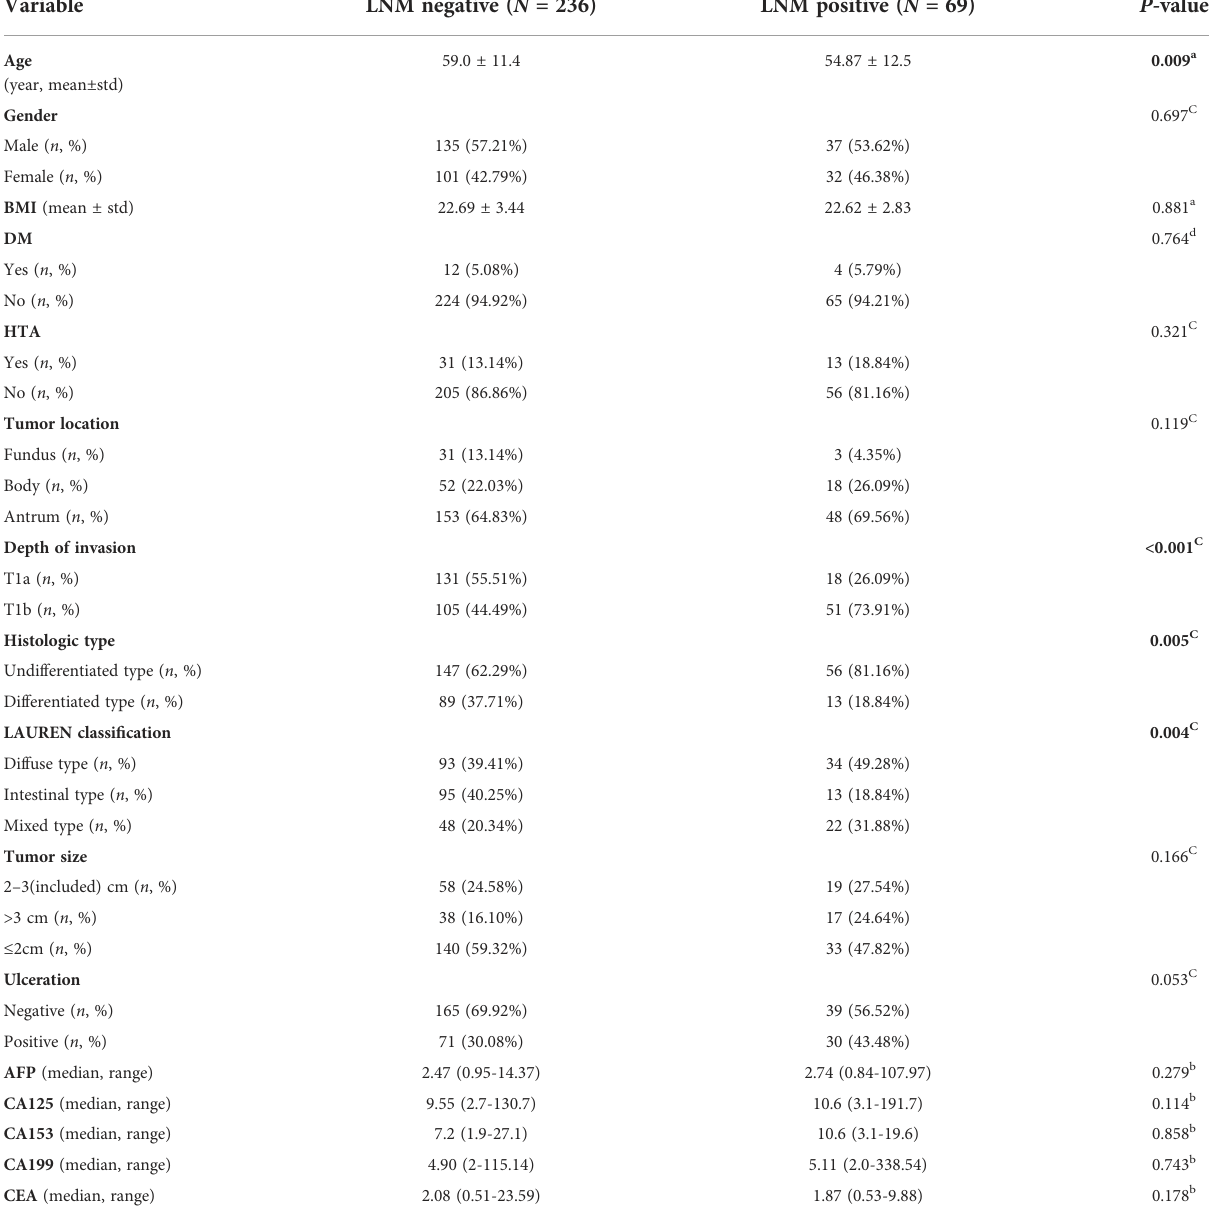
TABLE 1 Clinicopathologic characteristics of patient samples included in the present